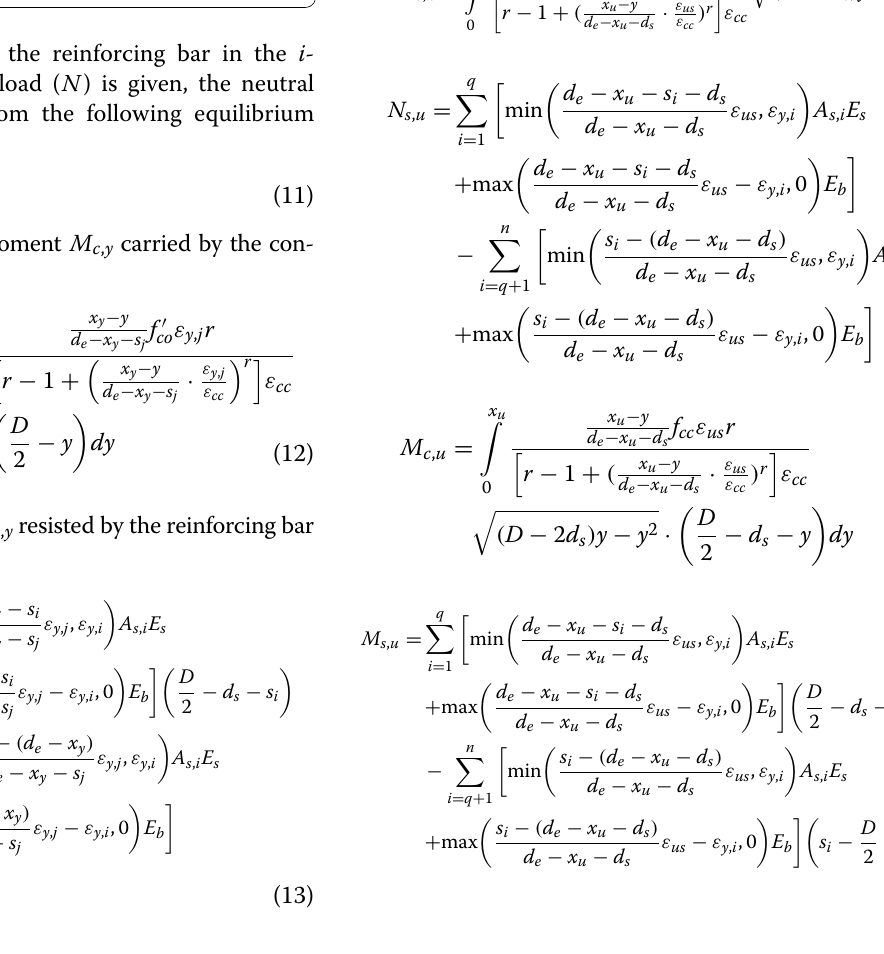
Fig. 4 Section analysis of circular column: a yield state; b failure